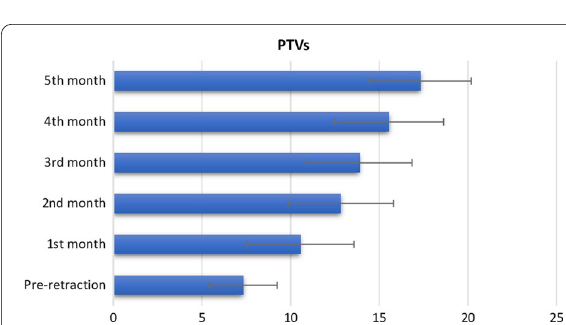
Fig. 3 Means and standard deviation of all PTVs of the maxillary canines’ pre-retraction and monthly